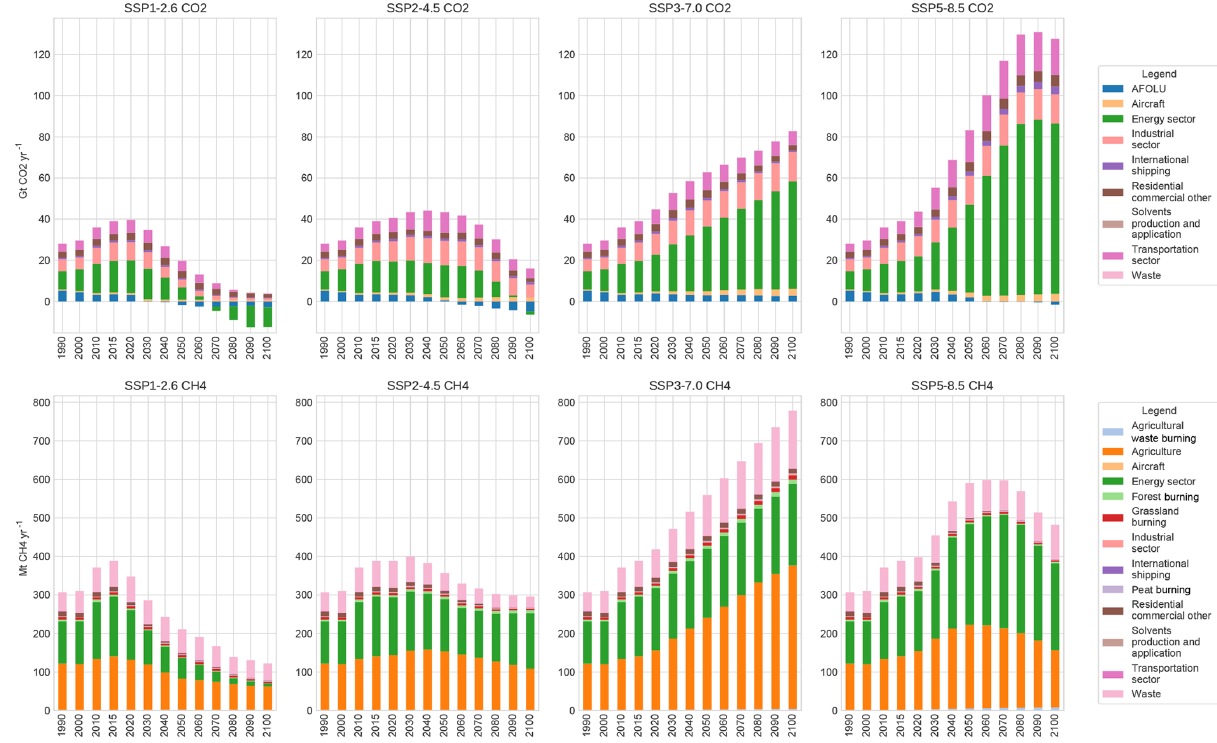
Figure 4. The sectoral contributions to CO 2 and CH 4 emissions for Tier-1